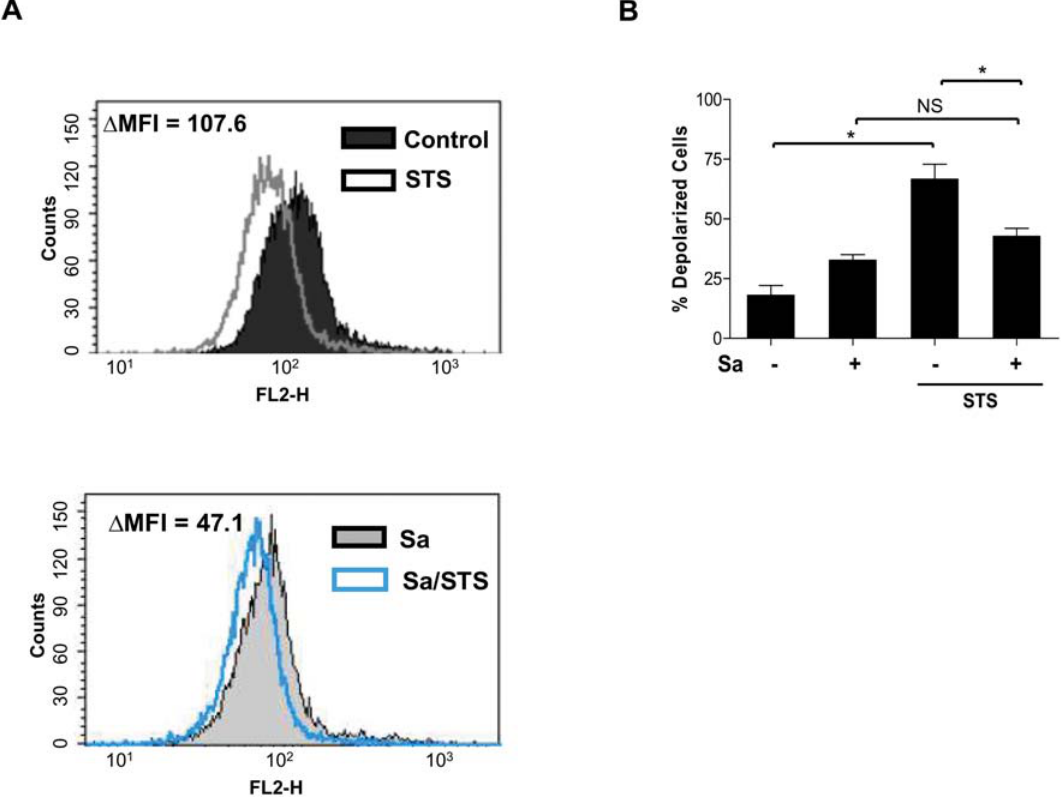
Figure 7. S. aureus phagocytosis partially protects infected hMDMs from an STS-induced drop in mitochondrial membrane potential. ( A ) Control and S. aureus -infected cells were stimulated with STS for 3 hours. Subsequently the cells were stained with CMXRos and subjected to flow cytometry analysis as described in the Materials and Methods. Representative histograms are shown. ( B ) The number of cells with depolarized mitochondrial membranes was determined. The diagram illustrates a result of several performed experiments using hMDMs derived from different donors. Bars represent the mean amount of depolarized cells calculated as % of the total analyzed cells 6 SD; *, p , 0.05; NS, not significant.